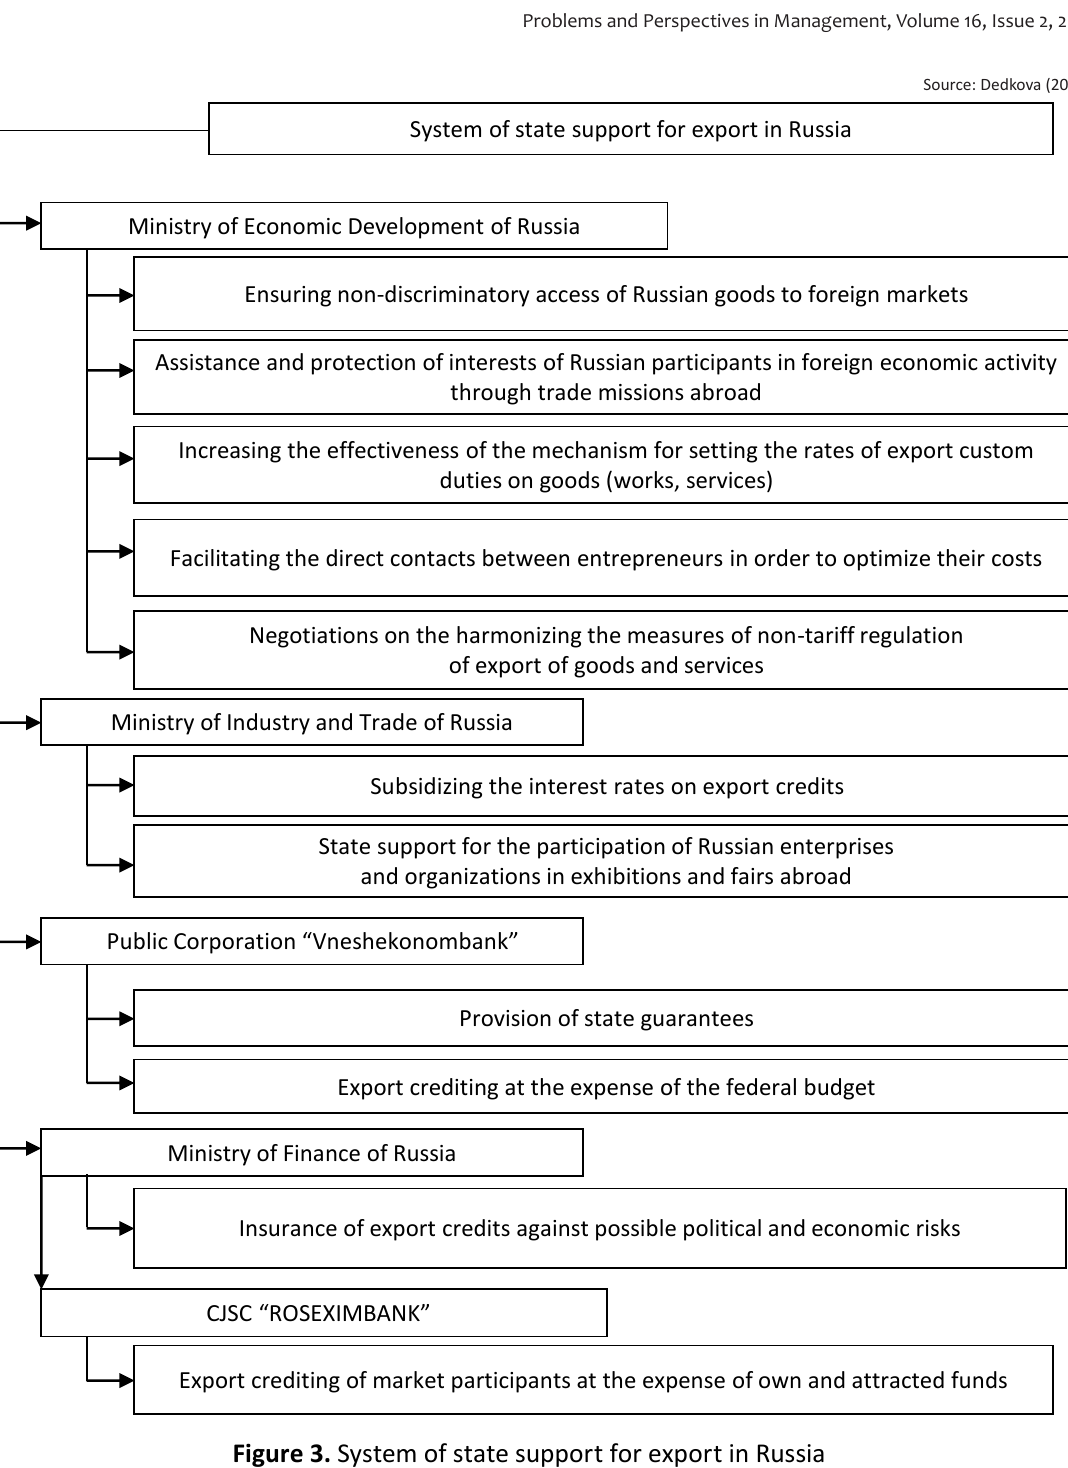
Figure 3. System of state support for export in